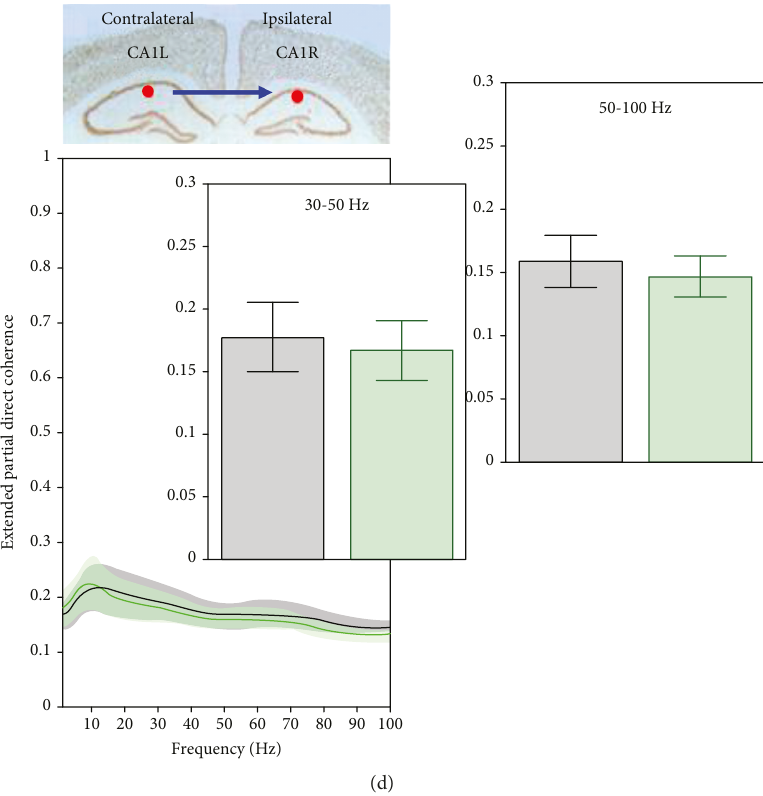
Figure 6: (a) Graphs showing the mean (across animals) global coherence e ffi ciency (with 95% CI) for bu ff er-injected (black) and K18-injected (green) mice, at week 1 (bu ff er n = 7 , K18 n = 8 ). Horizontal lines above bar plots with asterisks indicate the presence of signi fi cant di ff erence between bu ff er- and K18-injected animals (two-sample t -test: ∗ p value < 0 05 ). (b) The top line graph shows the mean (across animals) coherence values (with 95% CI) between CA1L and CA1R electrodes for bu ff er-injected (black) and K18-injected (green) mice, at week 10 for the frequency range 0-100 Hz. On the right-hand side, bar charts show the mean (across animals) coherence (with 95% CI) for both groups for the frequency range of interest. Bottom line graphs show the mean (across animals) partial coherence values (with 95% CI) between the same electrodes. On the right-hand side, bar charts show the mean partial coherence (with 95% CI) for both groups for the same frequency range, 0-100 Hz. Horizontal lines above bar plots with asterisks indicate the presence of signi fi cant di ff erence between bu ff er- and K18-injected animals (two-sample t -test; ∗ p value < 0 05 ). (c) Graphs showing the mean (across animals) extended partial directed coherence (with 95% CI) from CA1R to CA1L and (d) CA1L to CA1R for bu ff er-injected (black) and K18-injected (green) mice, at recording week 10. On the left-hand side, these data are presented in the form of a line graph, showing mean (across animal) extended partial directed coherence as a function of frequency (with 95% CI) for both groups for the frequency range 0-100 Hz. On the right-hand side, bar charts show the mean (across animals) extended partial directed coherence (with 95% CI) for both groups for frequency ranges 30-50 and 50-100 Hz. Horizontal lines above the bar plots with asterisks indicate the presence of signi fi cant di ff erence between bu ff er- and K18-injected animals (two-sample t -test; ∗ p value < 0 05 and ∗∗ p value < 0 01